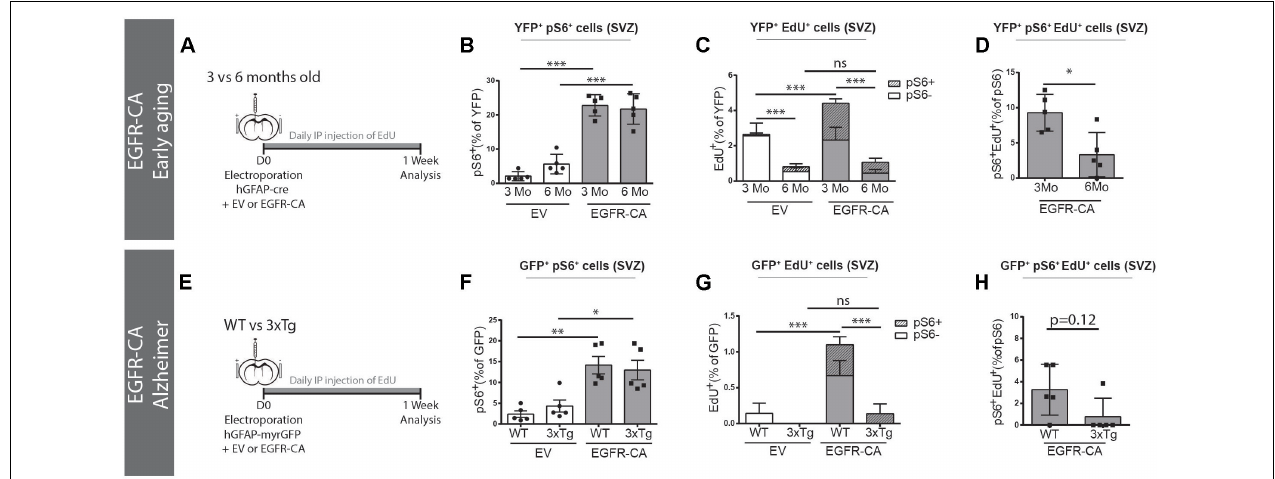
FIGURE 5 | Age and Alzheimer’s disease mutations prevent EGFR-induced qNSCs division. (A–D) Baseline and EGFR-CA-induced proliferation of electroporated GFAP + qNSCs cells in 3- versus 6-month-old ROSA26-stop-EYFP mice. (A) Paradigm for adult brain electroporation with hGFAP-cre plasmids, mixed with either EV or EGFR-CA plasmids, in Rosa26-stop-EYFP reporter mice. (B–D) 1 week post-electroporation, quantification of the percentage of YFP + recombined cells that are (B) primed (YFP + pS6+) or (C) dividing (YFP + EdU+). Note that YFP + cells in 3- and 6-month-old mice equally upregulated EGFR-induced pS6 but their division significantly increased only in the 3-month-old mice [two way ANOVA: age factor, F (1,16) = 141.1, p < 0.0001; EGFR-CA factor, F (1,16) = 19.62, p < 0.0083; interaction, F (1,16) = 9.072, p = 0.0083]. In (D) , the proportion of primed hGFAP + cells that incorporate EdU decreases between 3 and 6 months of age ( p = 0.0317, Mann–Whitney test). N = 5 per condition and age. Three month data is from Figure 4 . (E–H) Baseline and EGFR-CA-induced proliferation of GFAP + qNSCs in 3xTg-AD mice and their WT control strain. (E) Paradigm for adult brain electroporation with hGFAP-GFP plasmids, mixed with either EV